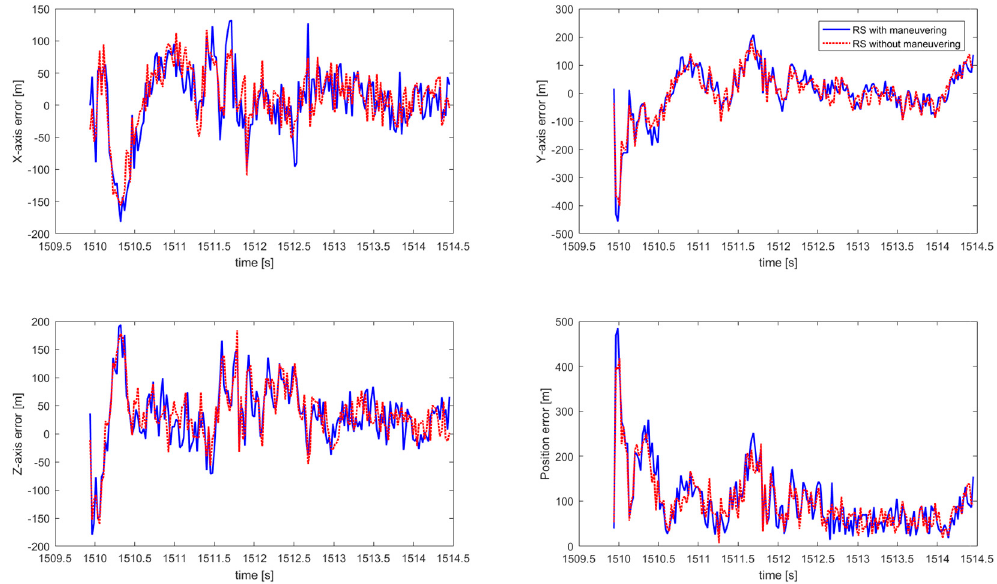
Figure 6. Errors of NCSO estimated orbit in epoch Earth-centered inertial ( EECI) coordinate system.